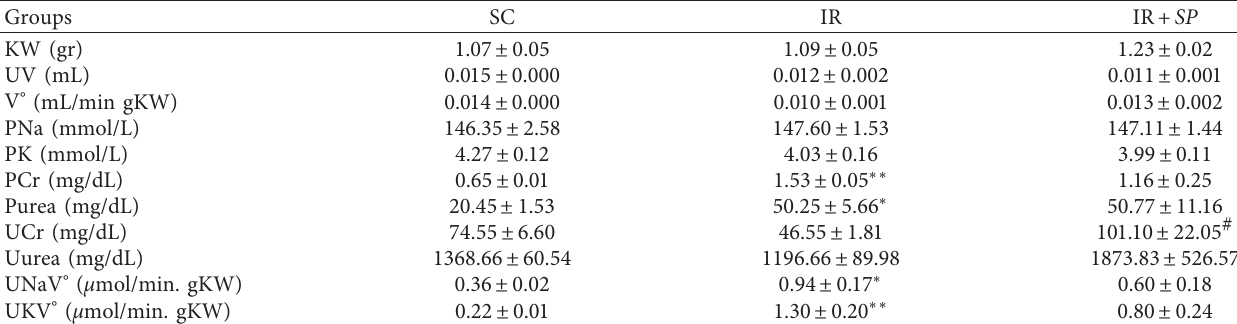
Table 1: Effects of Stachys pilifera extract on renal function